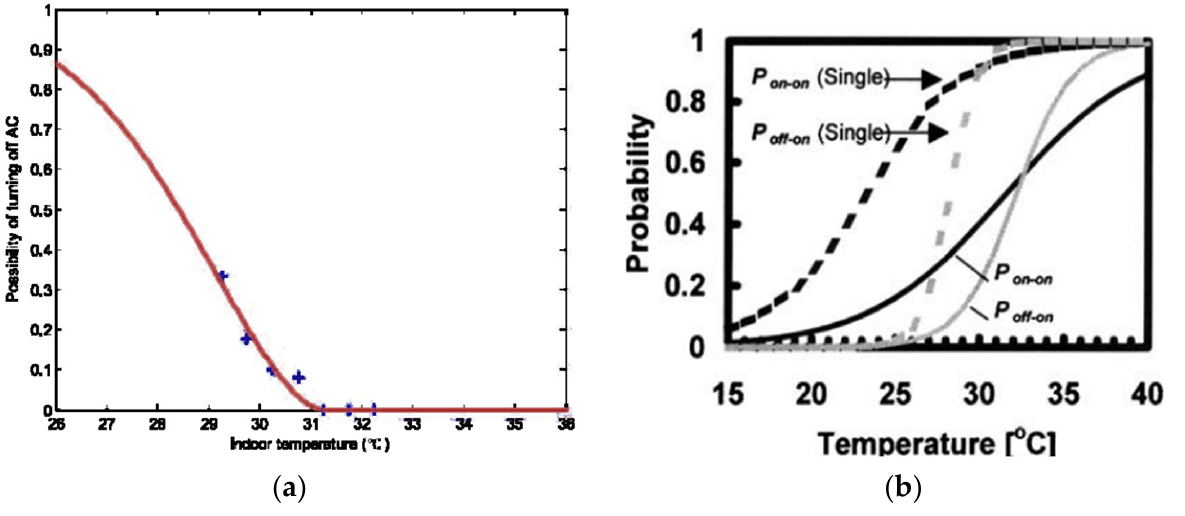
Figure 14. Air conditioning behavior models in other researches. ( a ) Ren’s research [28]; ( b ) Tan- imoto’s research [29].